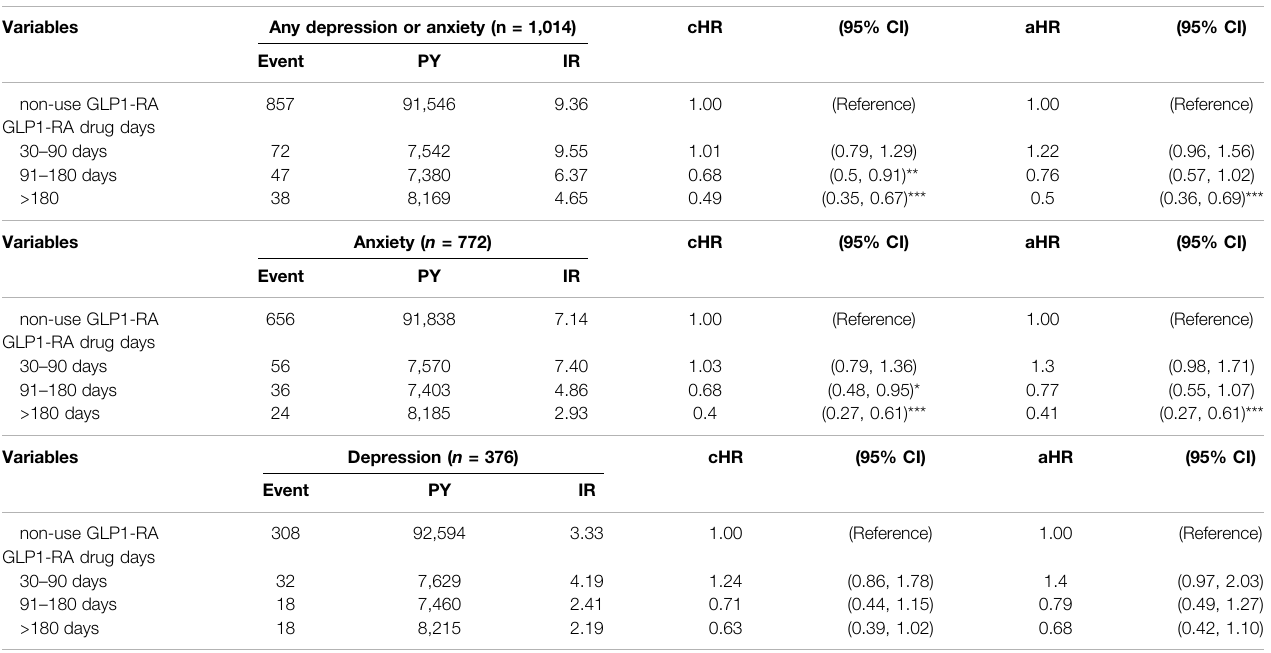
TABLE 5 | Risk of depression and anxiety associated with duration of GLP1-RA use. Variables